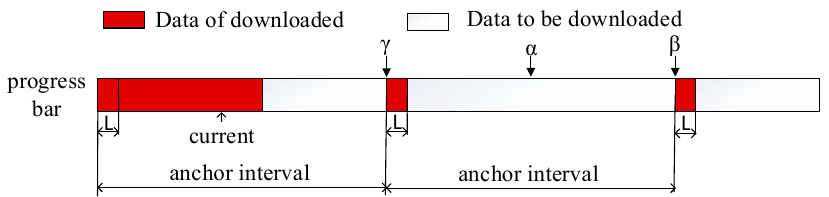
Figure 4. Seeking in a video.